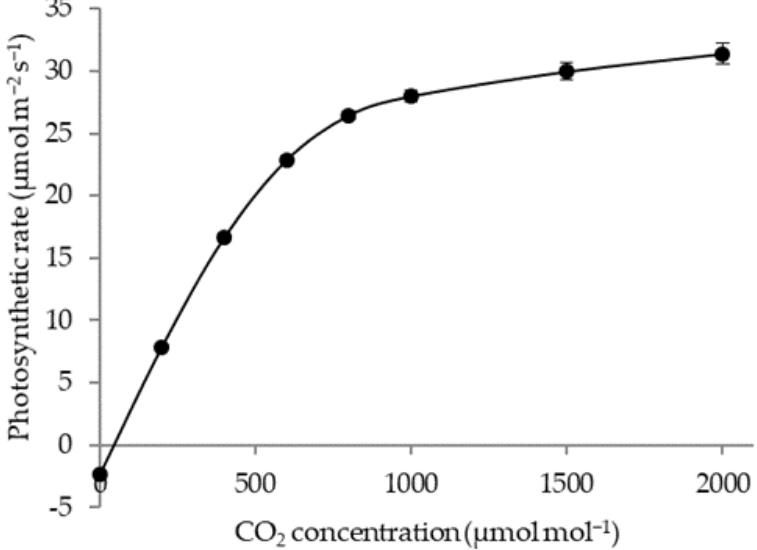
Figure 6. The relation of CO 2 concentration and photosynthetic rate of strawberry ‘Sagahonoka’. The